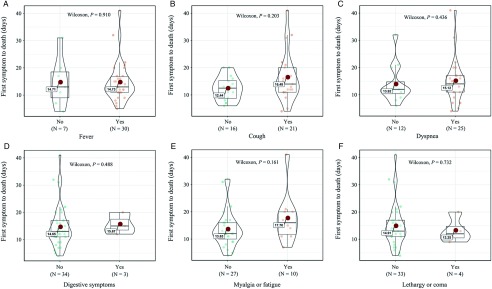
A-F, Comparison of the Influence of Clinical Features on the Time of First Symptom to Death (Days). Violin plots for (A) fever, (B) cough, (C) dyspnea, (D) digestive symptoms, (E) myalgia or fatigue, and (F) lethargy or coma.